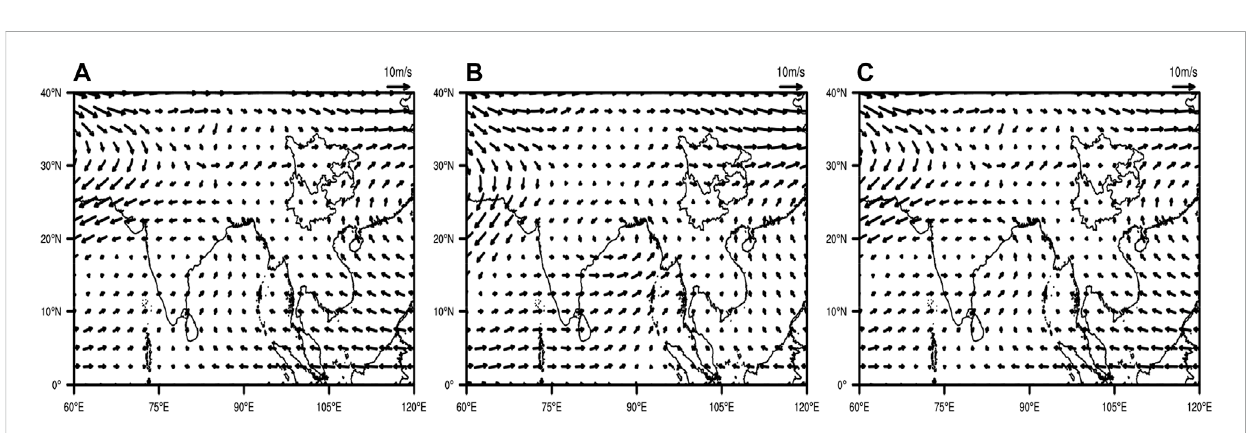
FIGURE 7 Mean horizontal wind (U, V) at 500 hPa (unit: m s − 1 ) in the domain (0 – 40 ° N, 60 ° E − 120 ° E) from 1992 to 2013 in the boreal summer (JJA): (A) CESM1 control modeling results without AHR; (B) ERA5 data results; (C) CESM1 modeling results with AHR.